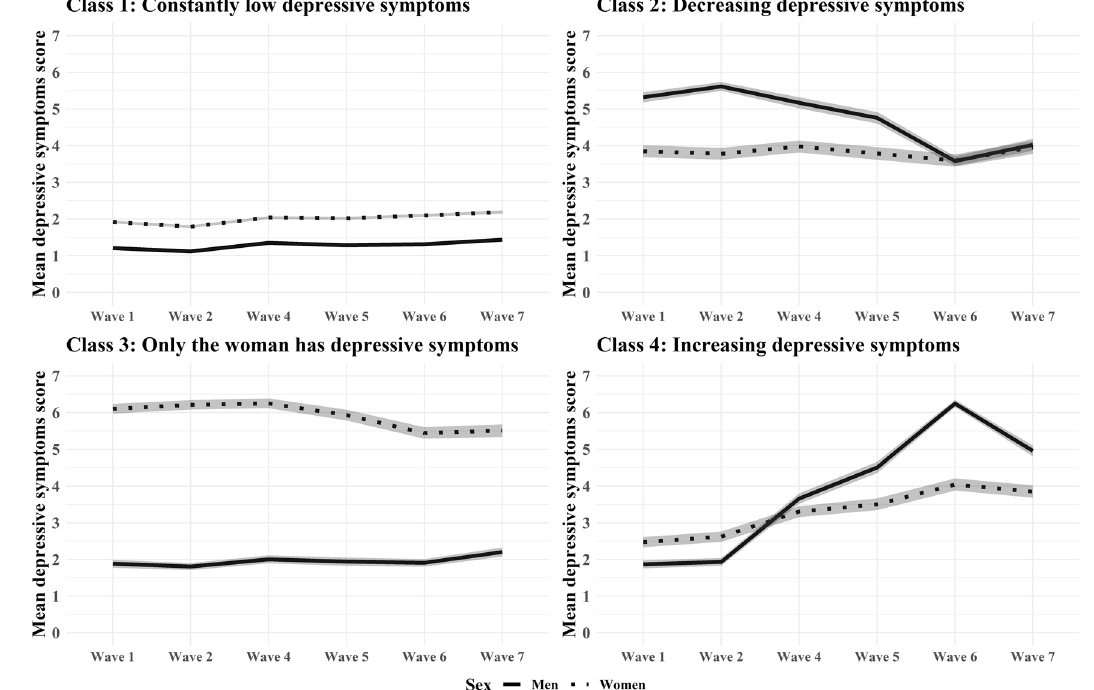
Fig. 1 Dyadic latent trajectories of depressive symptoms across four classes of couples. Measurements taken every 2 years between Wave 1 and Wave 7, except in Wave 3; the scale of the depression scores ranged from 0 to 12; men ’ s and women ’ s mean depressive symptoms were presented in solid and dashed lines, respectively; 95% con fi dence intervals were shadowed in